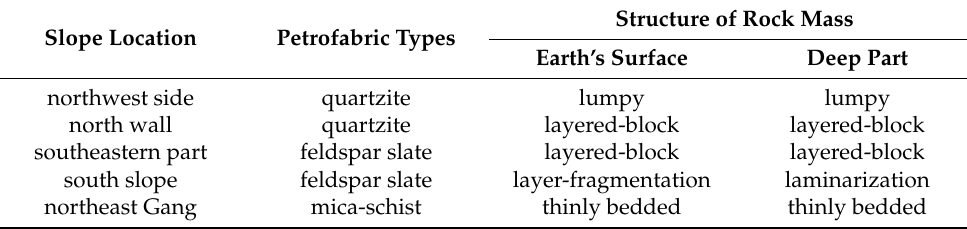
Table 1. Classification table of slope rock mass structure.